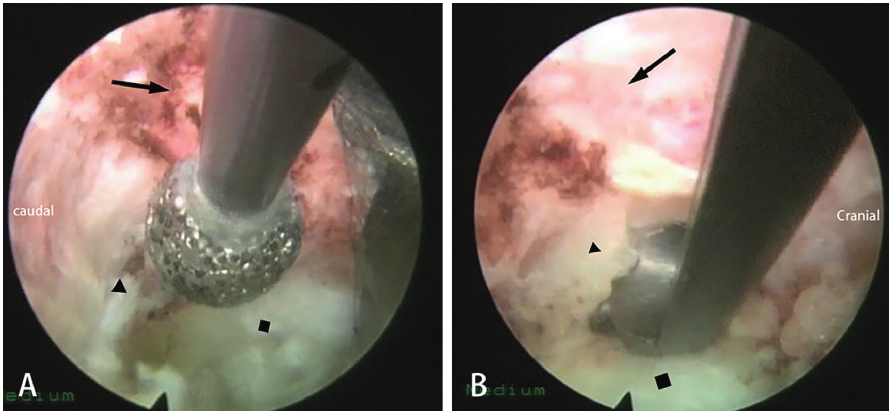
Figure 3: Endoscopic foraminoplasty by the high-speed diamond burr (a) and Kerrison rongeur (b). The articular process, the ligamentum flavum, and the thoracic